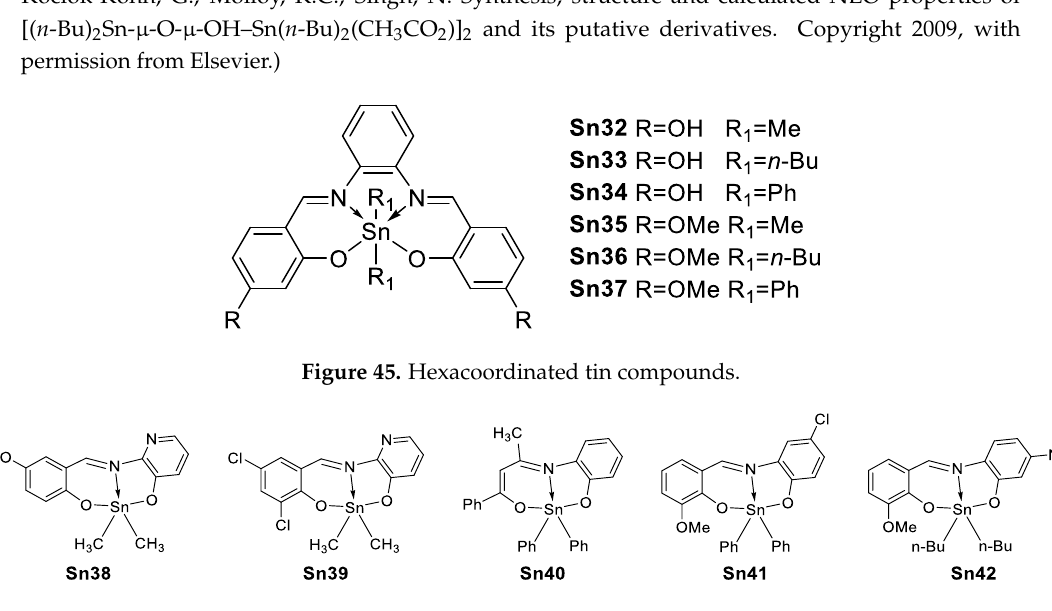
Figure 46. Organotin compounds investigated by Şirikci et al. [77].